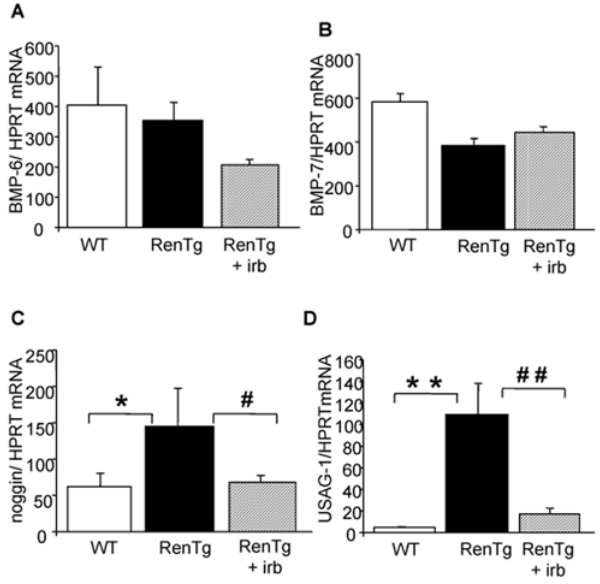
Figure 9. Expression of BMPs and their endogenous inhibitors during progression and reversal of chronic kidney disease. Quantitative RT-PCR analysis of BMP6 (A) and BMP7 (B) and their endogenous inhibitors noggin (C) and USAG-1 (D) in the renal cortex of wild type and RenTg mice before and after irbesartan treatment. Note that while the expression of BMPs did not change, the expression of their endogenous antagonists noggin and USAG-1 was increased in RenTg and decreased to normal levels following treatment with the AT1 receptor antagonist. Values are mean 6 SEM; n=5, 9 and 13 for wild type and RenTg mice before and after irbesartan, respectively; * P , 0,05 or ** P , 0,01 vs WT; # P , 0,05 or ## P , 0,001 vs RenTg.